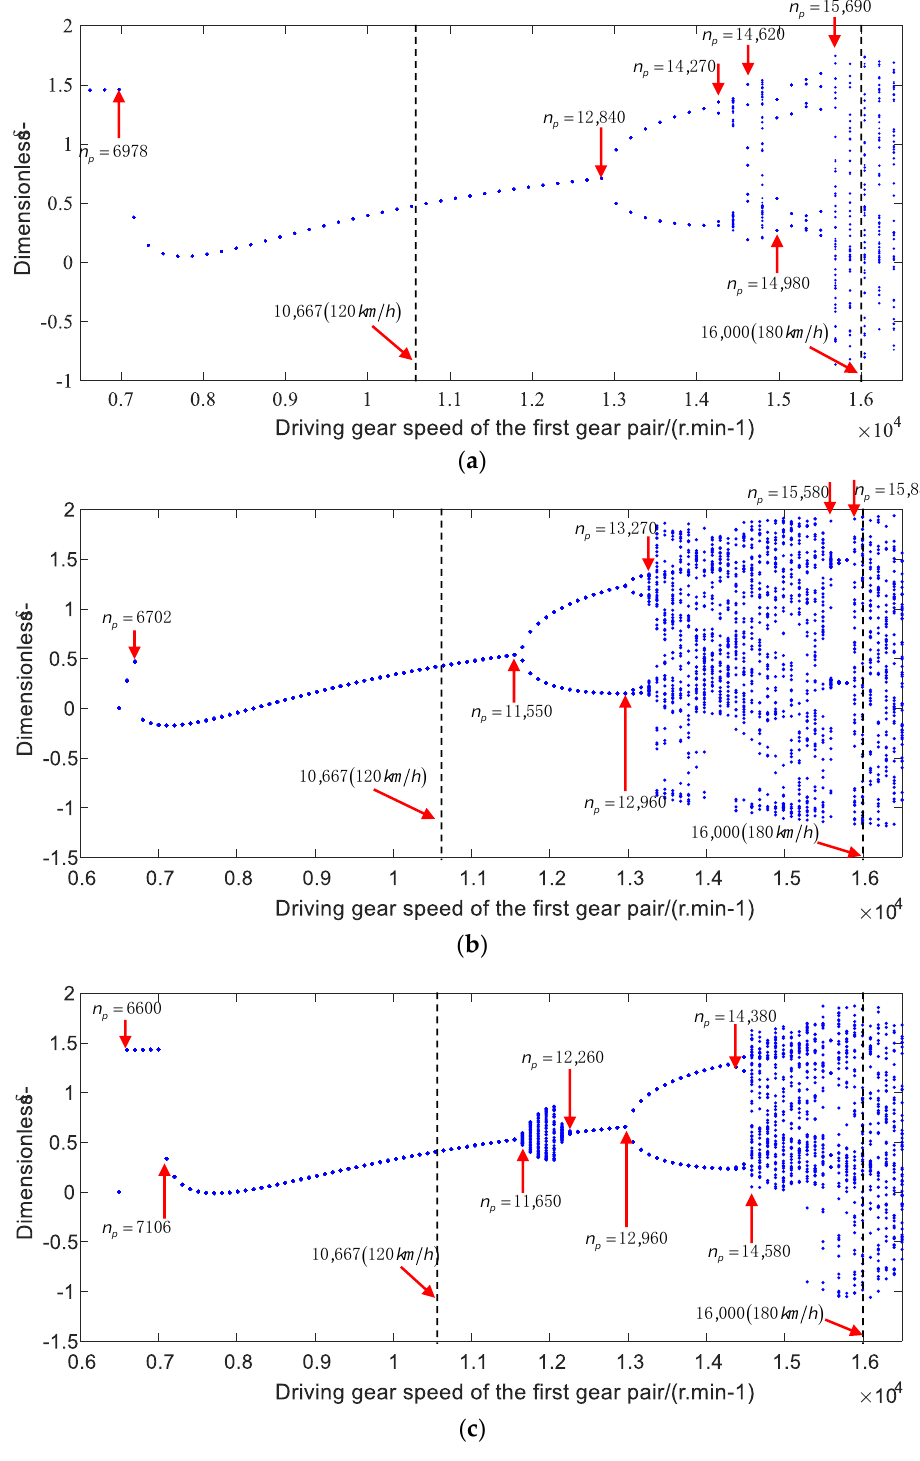
Figure 15. The bifurcated diagrams of gear system for the decelerating working condition: ( a ) constant bearing stiffness, ( b ) variable bearing stiffness values without considering the influence of thermal deformation, and ( c ) variable bearing stiffness values considering the influence of thermal deformation.